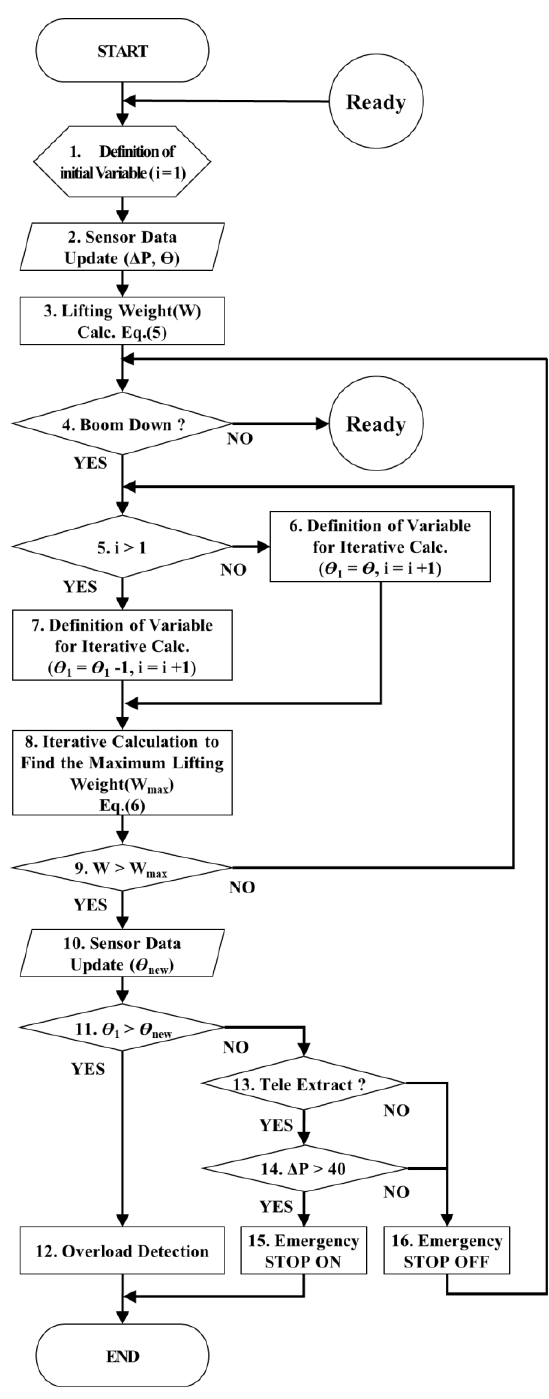
Figure 9. Auto moment limiter control algorithm.